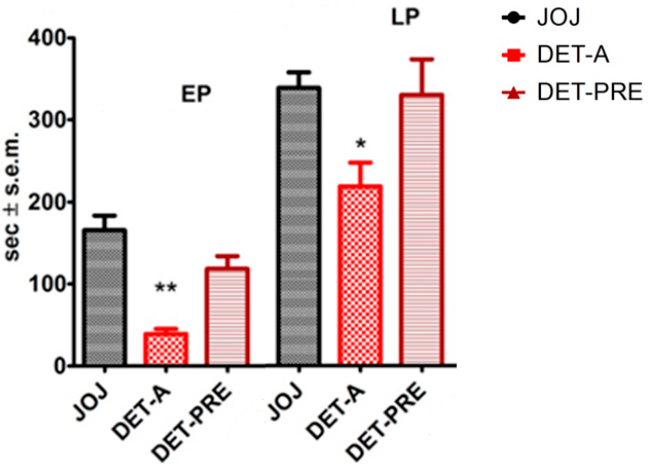
Figure 4. Analgesic effect of the transdermal administration of the deterpenated fraction of the essential oil of bergamot (DET), enriched in linalyl acetate, on licking/biting behavior in the formalin test. The deterpenated fraction of the essential oil of bergamot (DET), enriched in linalyl acetate, transdermally administered immediately after formalin injection (DET-A), decreased the licking/biting time in the early and in the late phase (EP, LP) of the formalin test. Administered as 5 min pretreatment followed by washout (DET-PRE) and application of JOJ, the DET fraction did not reduce the licking/biting time in s. Overall licking/biting time is expressed as time in s ± SEM during the EP (0–10 min) and the LP (10–30 min). One-way ANOVA followed by Bonferroni test; n = 8; * p < 0.05, ** p <